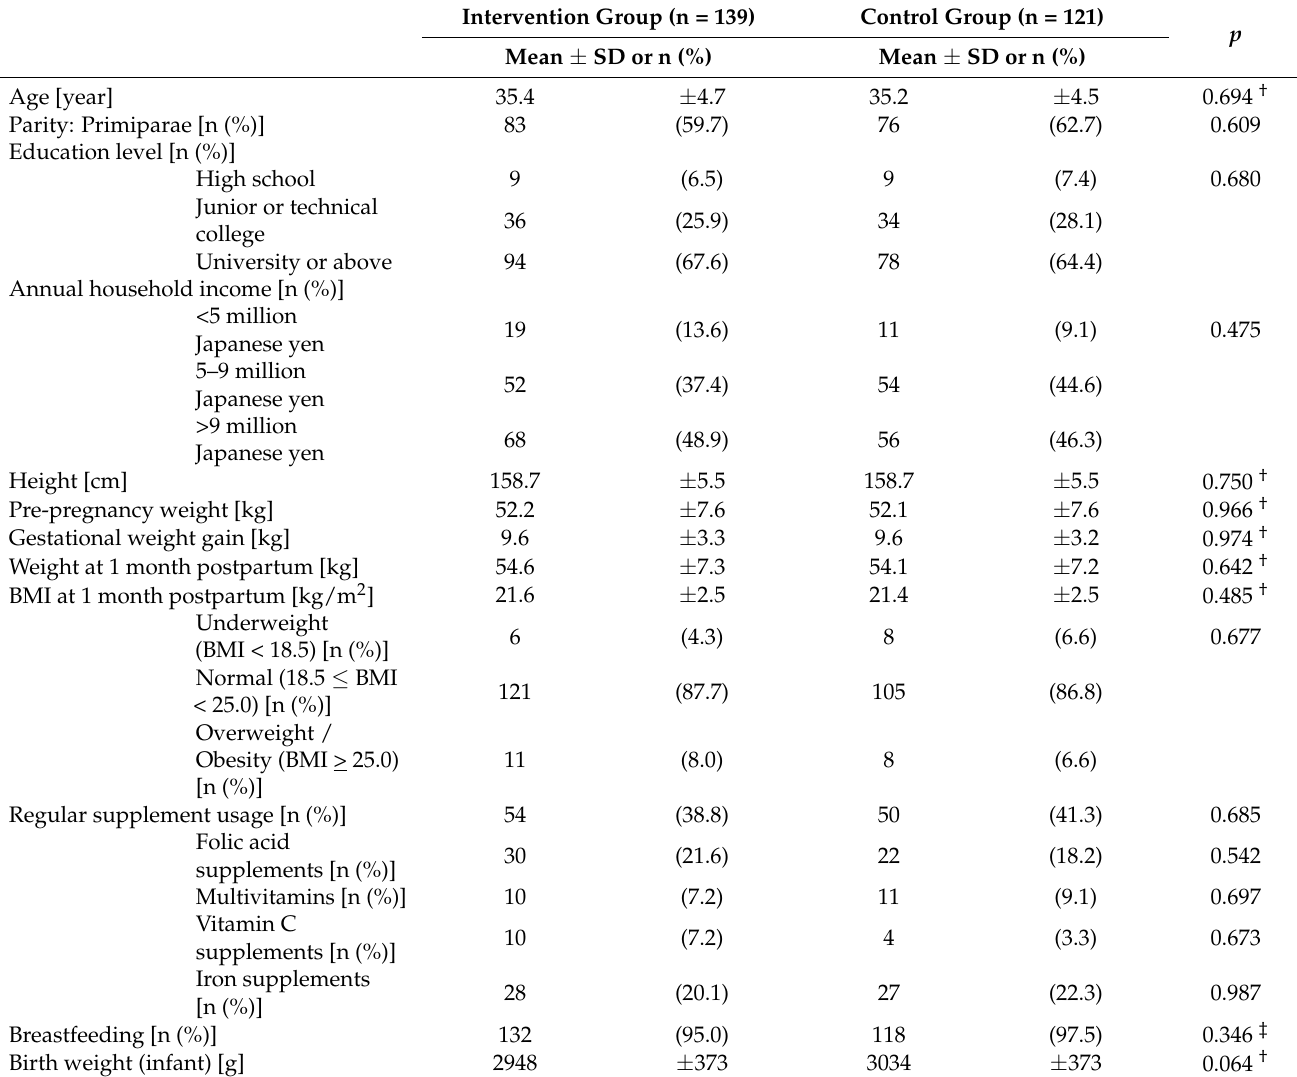
Table 1. Participant characteristics at 1 month